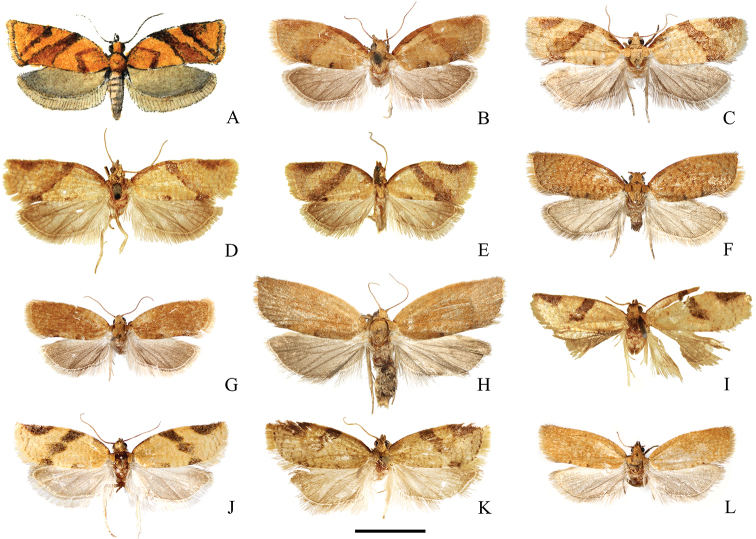
Adults of Clepsis
consimilana species group A–HC.
consimilana: A illustration from the original description of Tortrix
consimilanaB neotype of T.
consimilanaC male, Bulgaria D lectotype of T.
unifascianaE Holotype of Siclobola
placidaF male, Poland G female, Italy H female, Poland I–LC.
eatoniana: I Lectotype of T.
eatonianaJ male, Spain K Lectotype of Tortrix
xylotoma (courtesy by D. Lees and Trustees of the Natural History Museum, London) L female, Spain. Scale bar: 5 mm, all to scale.